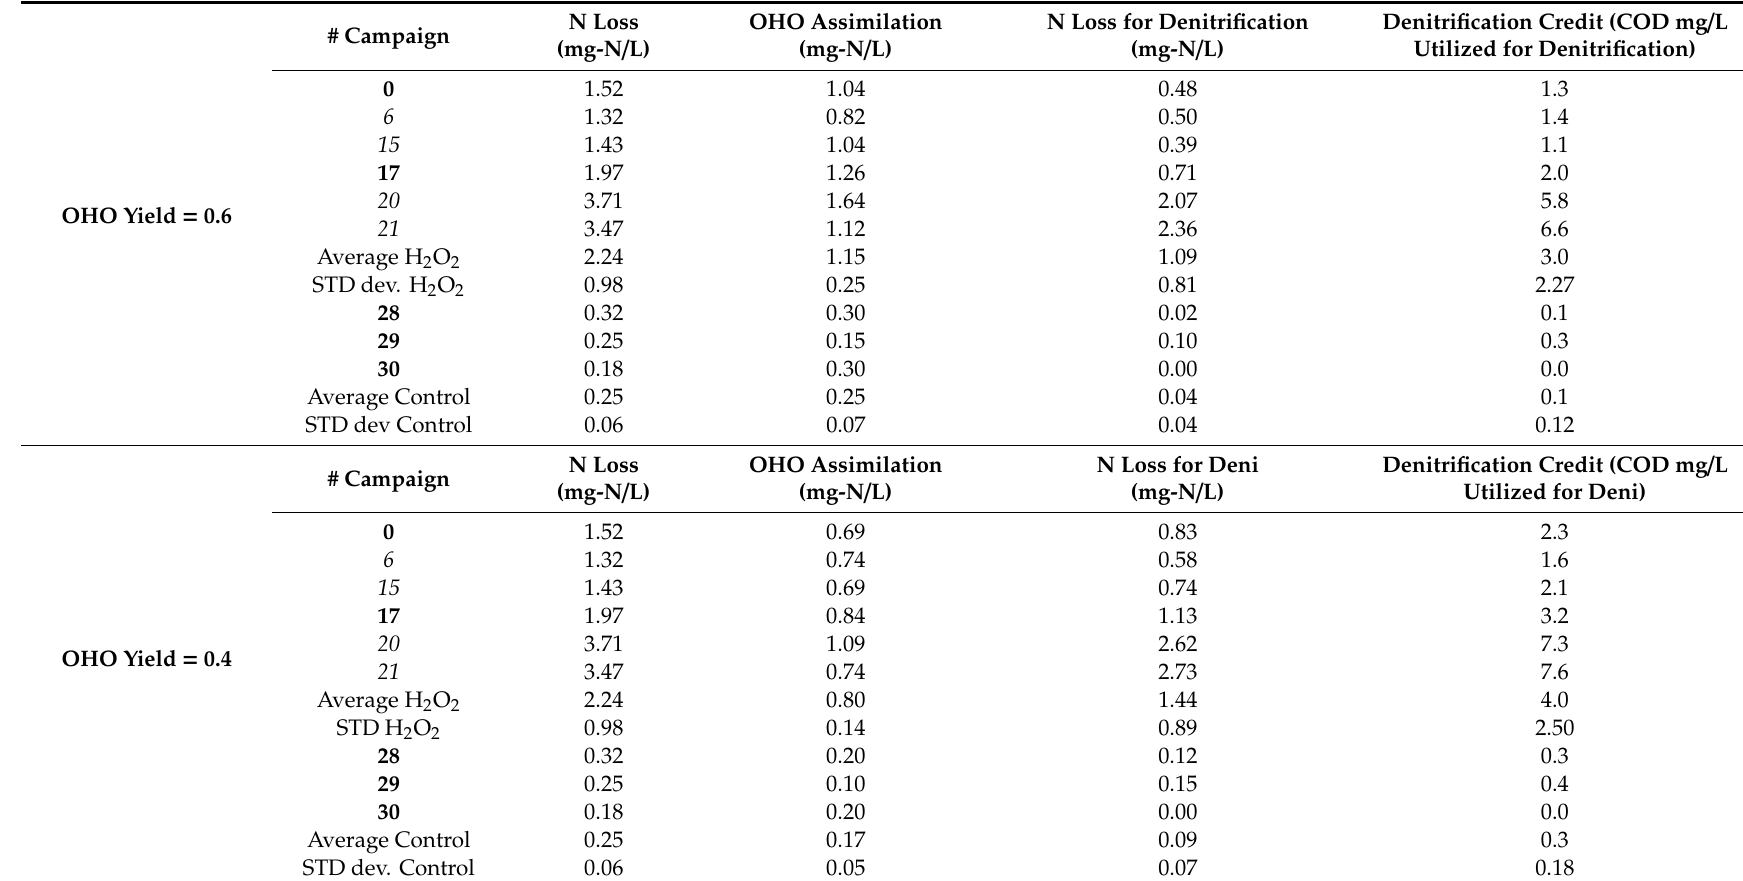
Table A1. Nitrogen mass balance of the biofilter system with and without H 2 O 2 .